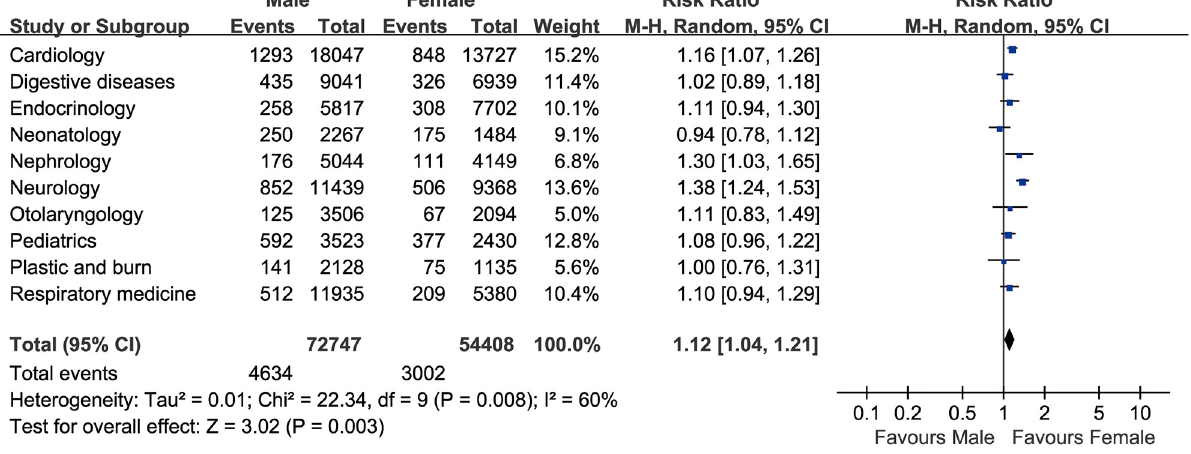
Fig 1. The pooled OR of hemolysis based on the top ten high hemolysis incidence departments (n = 127,155).